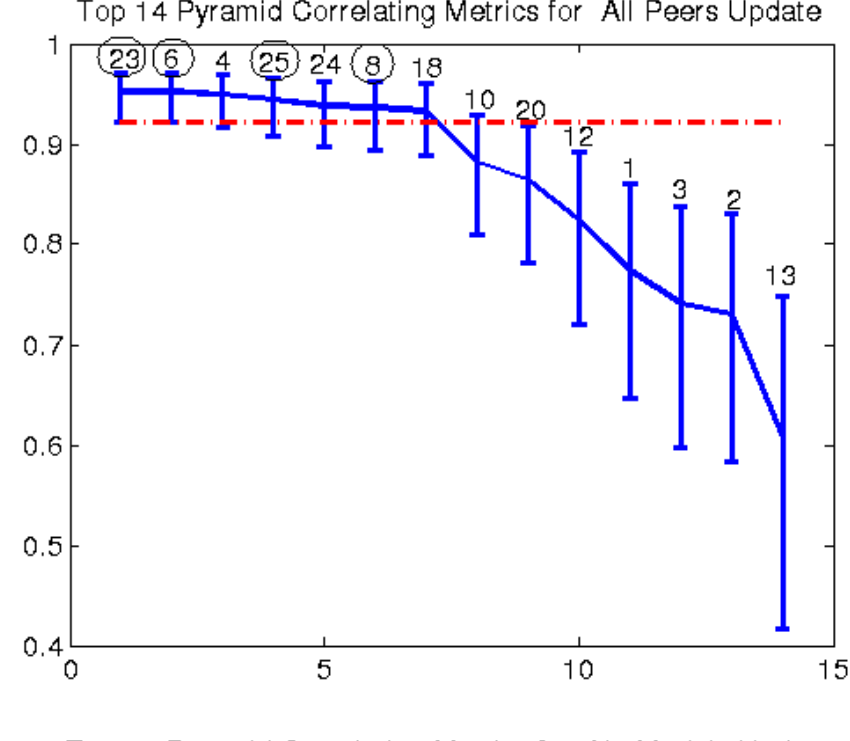
Figure 2. Pearson correlation with pyramid top 14 AESOP metrics all peers and no models